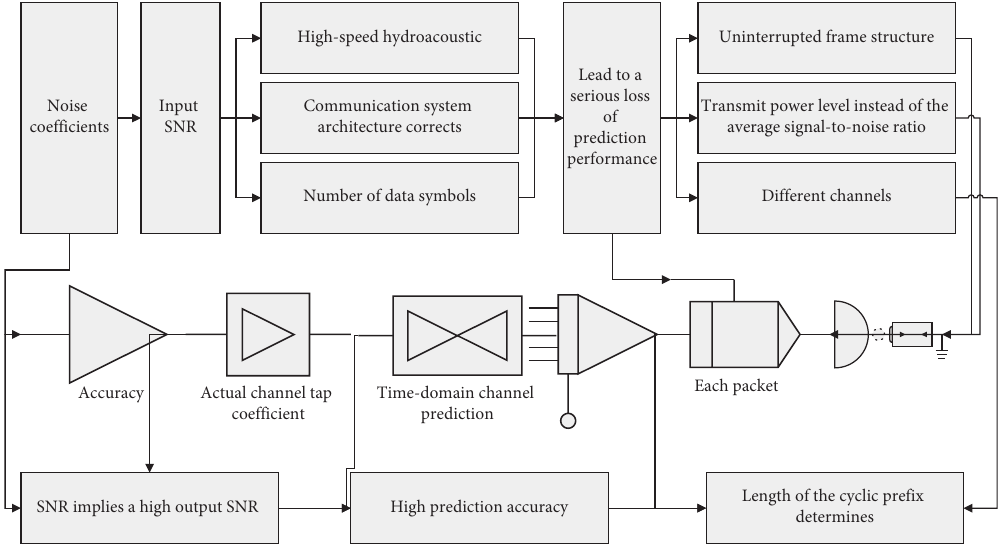
Figure 3: Frequency domain equalizer